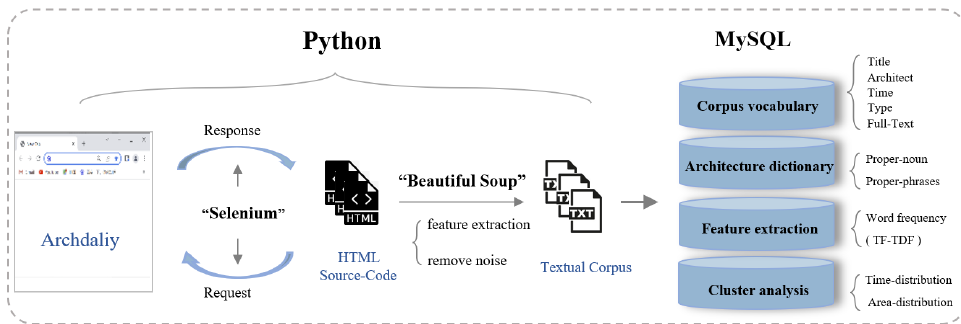
Figure 2. Data collection